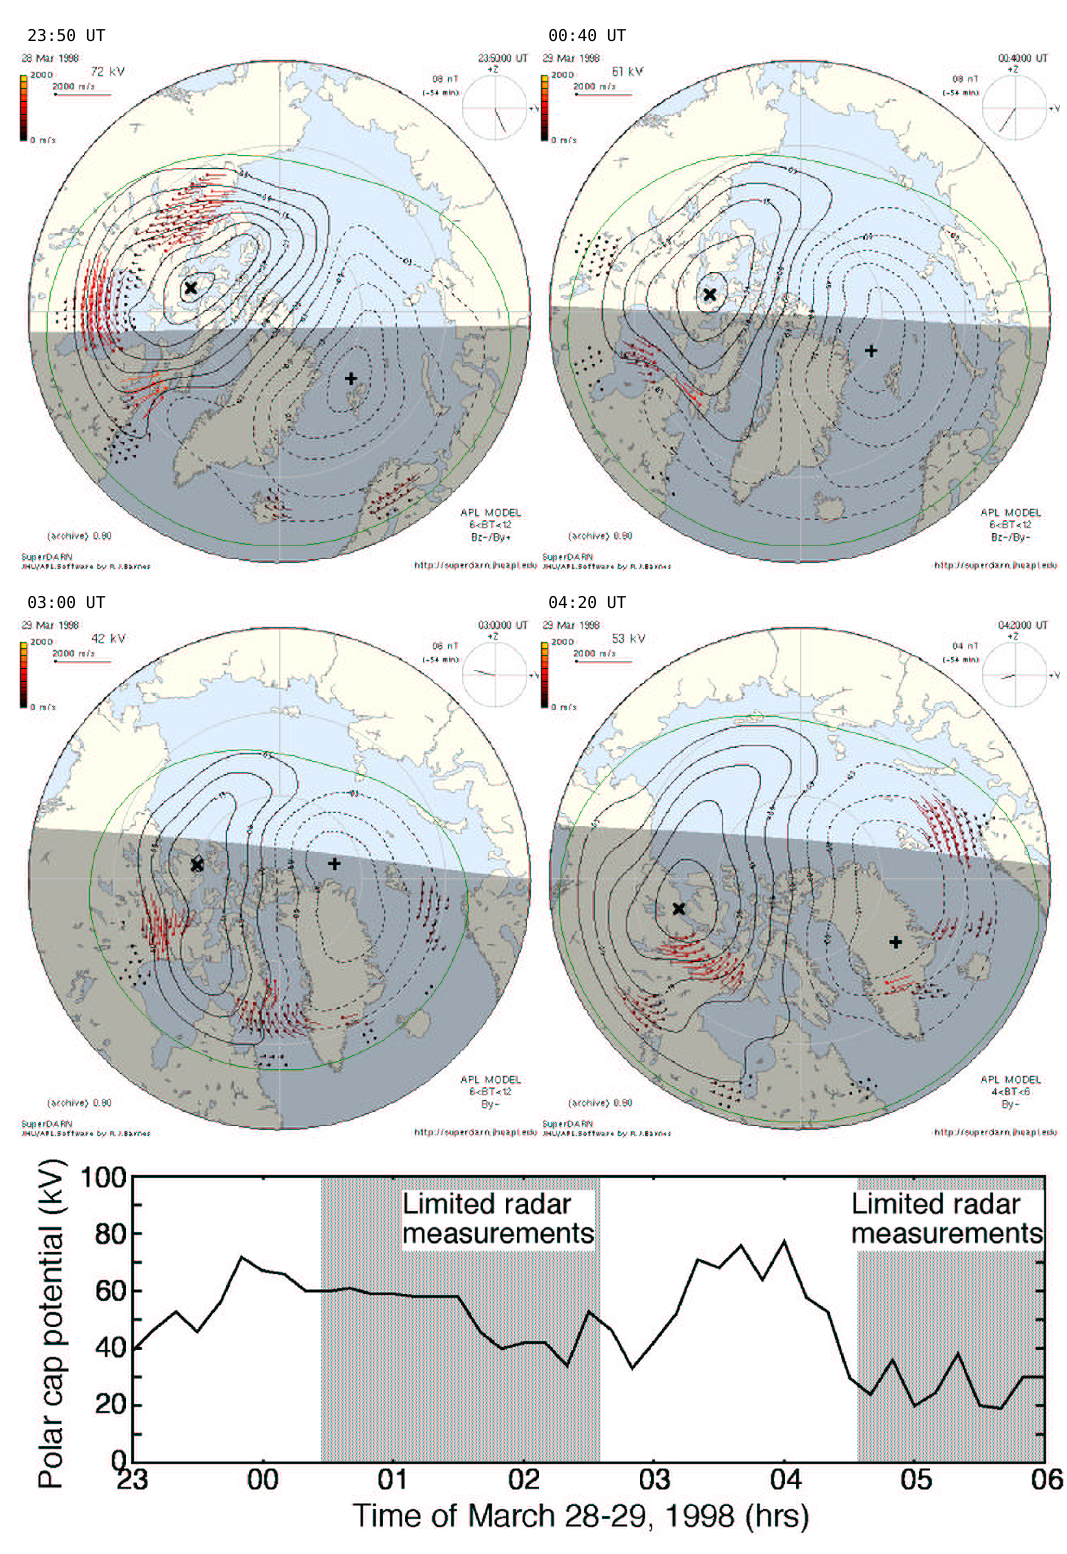
Fig. 4. SuperDARN radar observations of Northern Hemisphere convection at the onset (23:50 UT), maximum of the first substorm (00:40 UT), minimum between the substorms (03:00 UT), and close to the maximum of the second substorm (04:20 UT). Below is the polar cap potential derived from the radar measurements for the entire